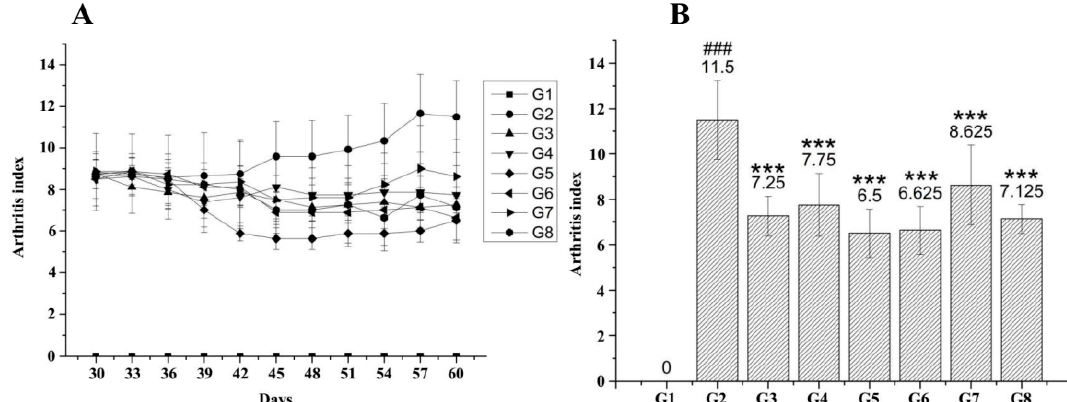
Figure 7. HM-3-Fc treatments decreased arthritis grading of CIA mice. Mice were immunized with an emulsion of bull collagen type II and Complete Freund’s adjuvant (CFA) on day 0 and subsequently with an injection of incomplete Freund’s adjuvant (IFA) on day 21. On the 30th day of the experiments, mice were randomized in different groups for treatments with different drugs. Arthritis grading ( A ) of mice in each group was measured every three days until the 60th day. Comparison of arthritis index of the mice in each group was shown in panel ( B ). For G2, n = 12; for G3–G8, n = 8. ### p < 0.001 vs. G1. *** p < 0.001 vs. G2.